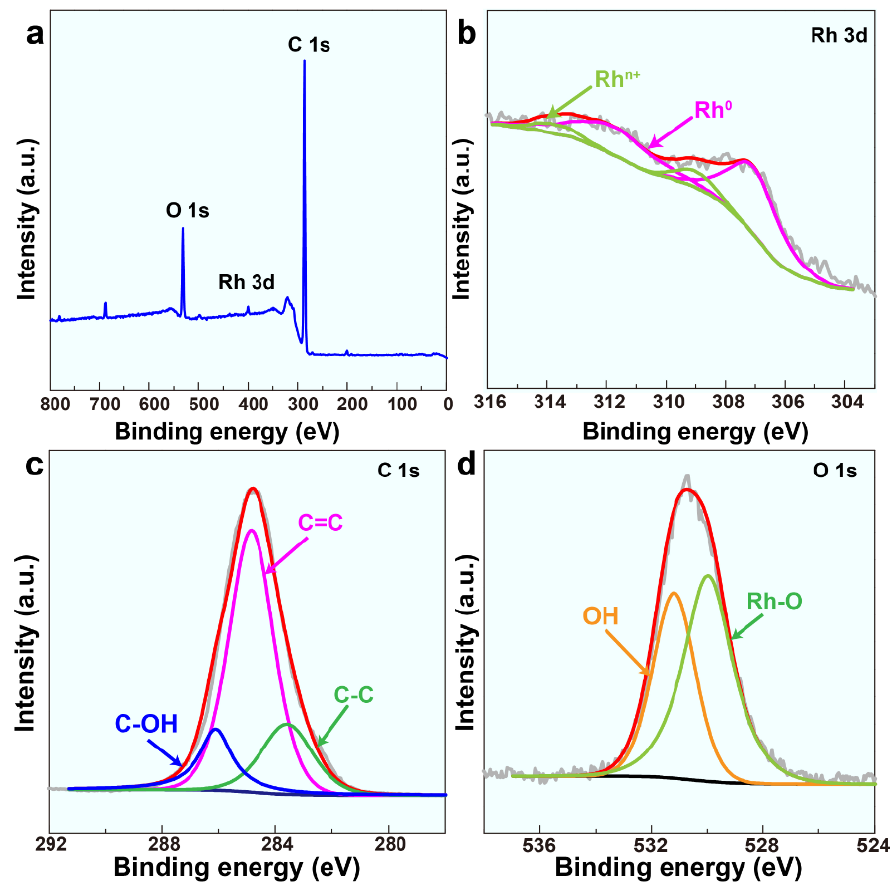
Figure 2. ( a ) XPS full spectrum of Rh / nano-DA. High-resolution XPS spectra of ( b ) Rh 3d; ( c ) C 1s; ( d ) O 1s.